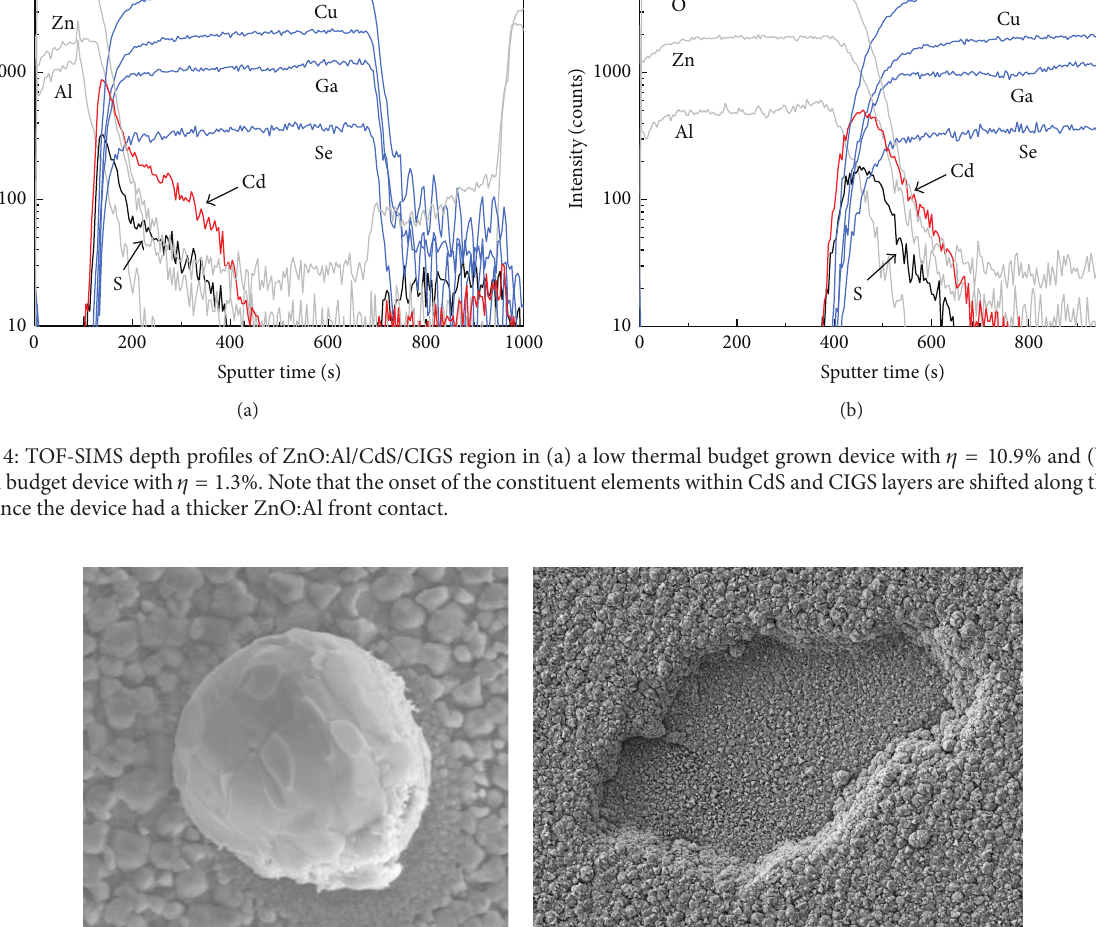
particles were found x particles are no longer seen, but numerous craters x